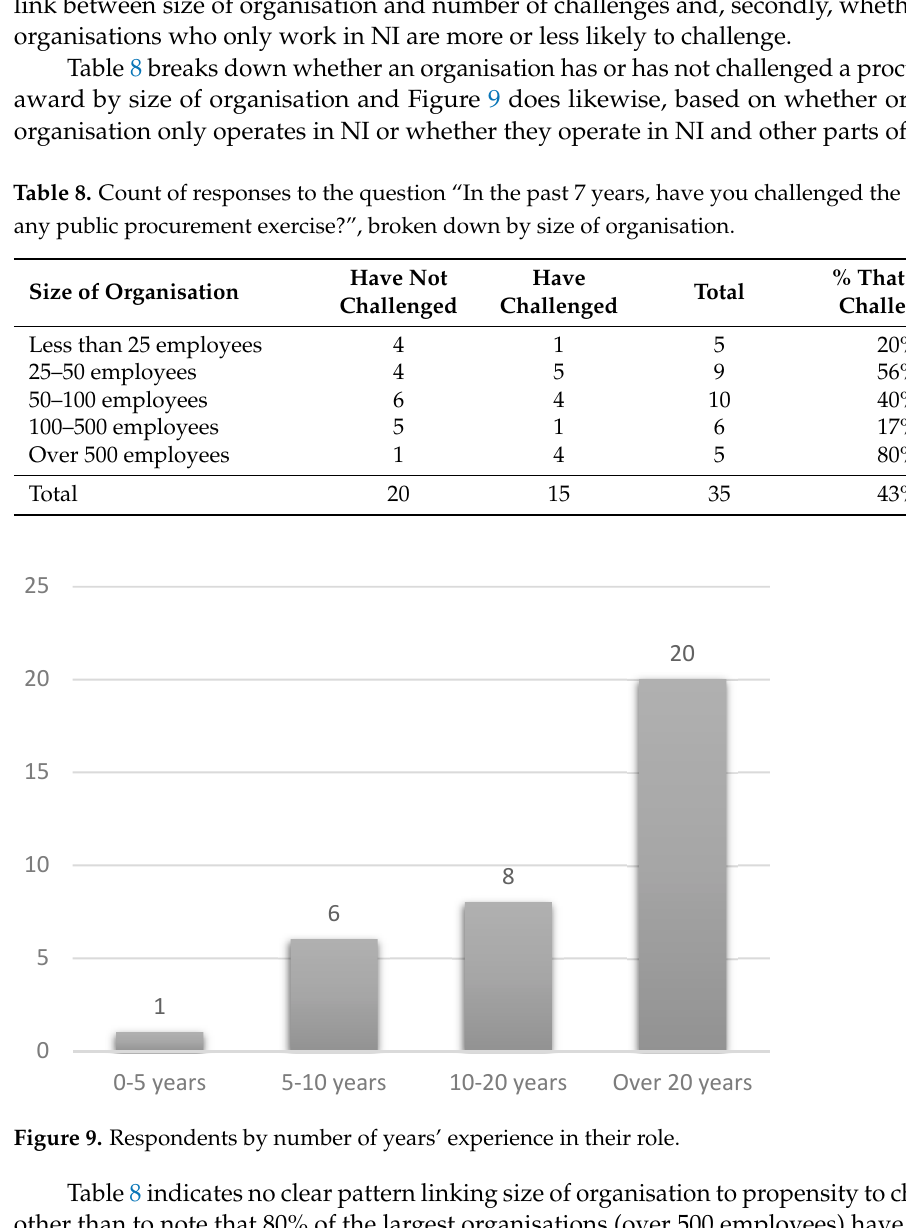
Table 9. Thematic analysis on views as to whether procurement in NI is well managed or not. Theme